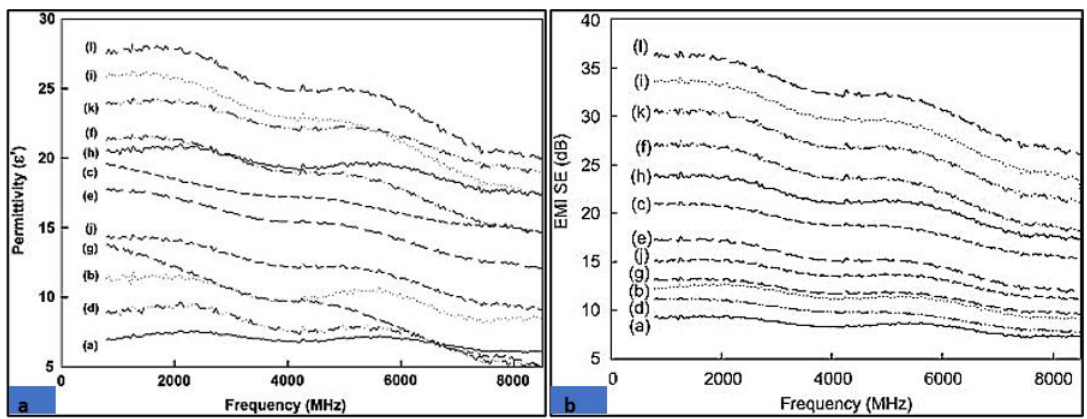
Figure 17. Dielectric constant of PAN as a function of graphene nano flakes concentrations [161]. According to Im et al. (2011), the increase in dielectric property of permittivity increases the electromagnetic interference shielding effectiveness (EMI-SE), as shown in Figure 18a,b. The permittivity of carbon fibers with different proportions of ZrO 2 is shown in Figure 18a, and the EMI-SE of the same proportions is shown in Figure 18b. This relationship is more evident below 2000 MHz [162].